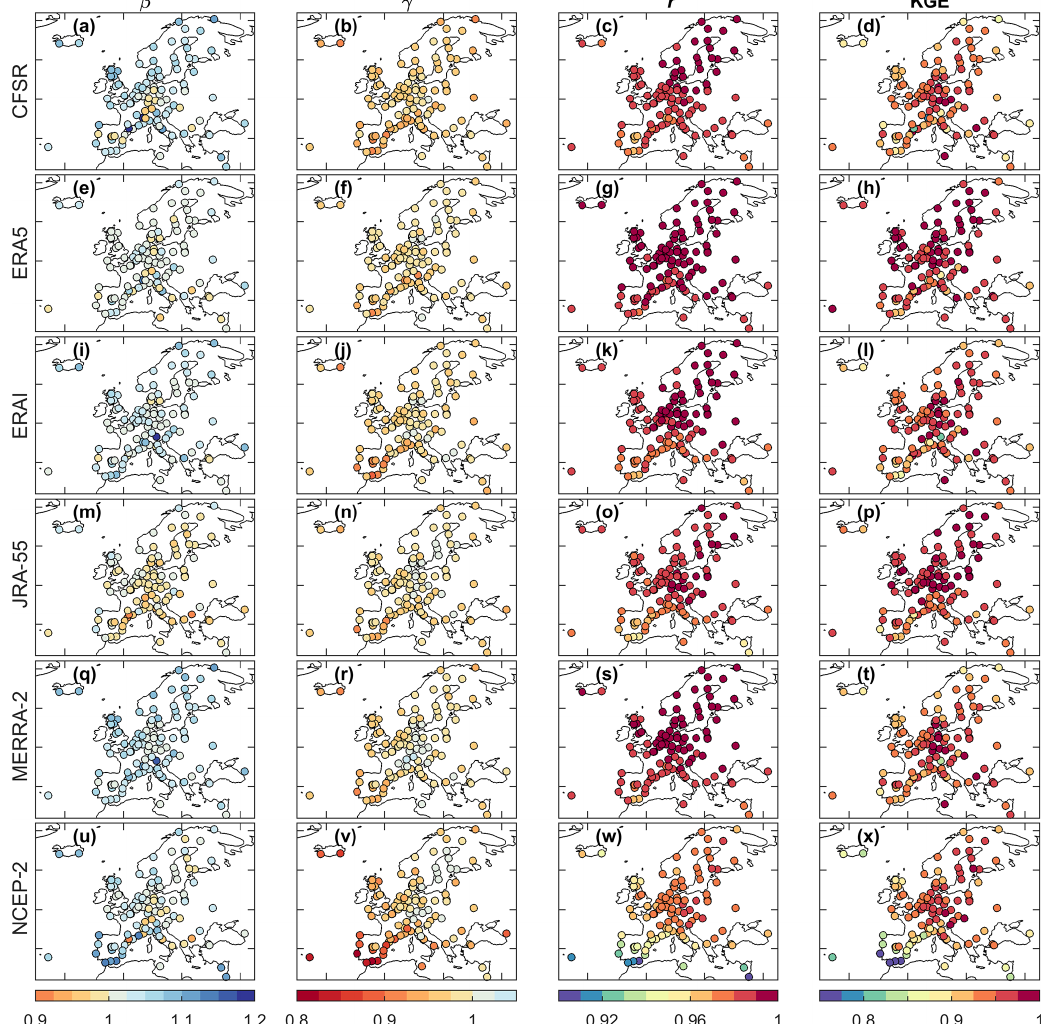
Figure 4. Plots of the KGE parameters for the daily IWV time series of the 108 GPS stations. β and γ indicate the consistencies in the mean and variability, respectively. r indicates the Pearson correlation coefficient between the GPS and reanalyses time series. With perfect consistencies in mean, variability, and correlation, β , γ , and r are identical to 1, respectively. When β , γ , and r are identical to 1, the KGE score will reach its maximum value of